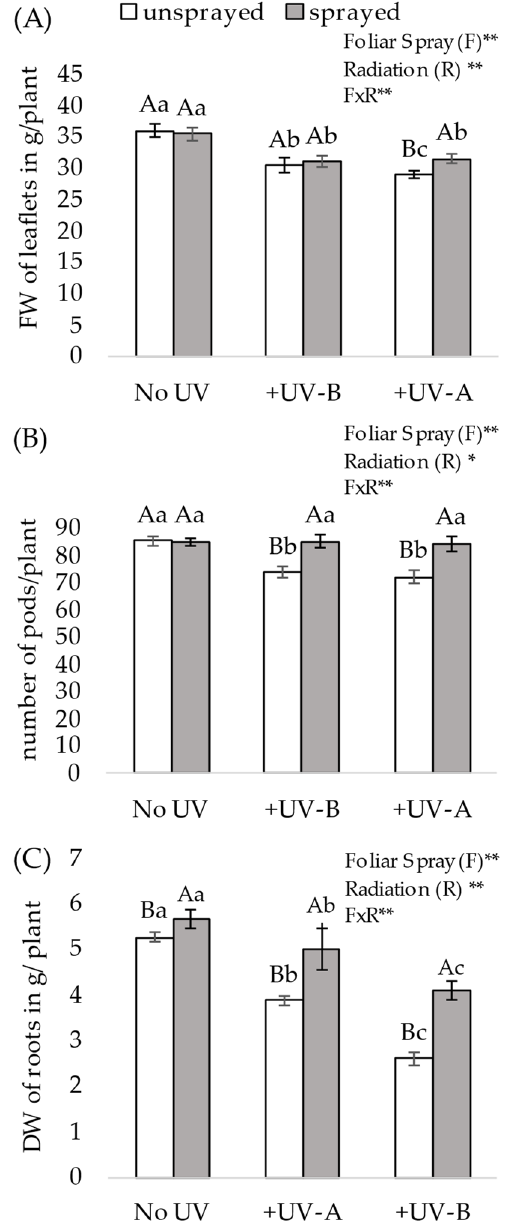
Figure 4. Effect of UVR regimen and/or treatments on biometrics of ( A ) fresh weight (FW) of total leaflets per plant; ( B ) number of pods per plant and ( C ) dry weight (DW) of roots per plant. The same uppercase letters within sprayed/unsprayed (intra-treatment) or the same lowercase letters across UVR regimens (inter-treatment) indicate no difference using Tukey’s test ( p < 0.05). * and ** denote significance among foliar spray and UV radiation, according to the Tukey test (ANOVA).